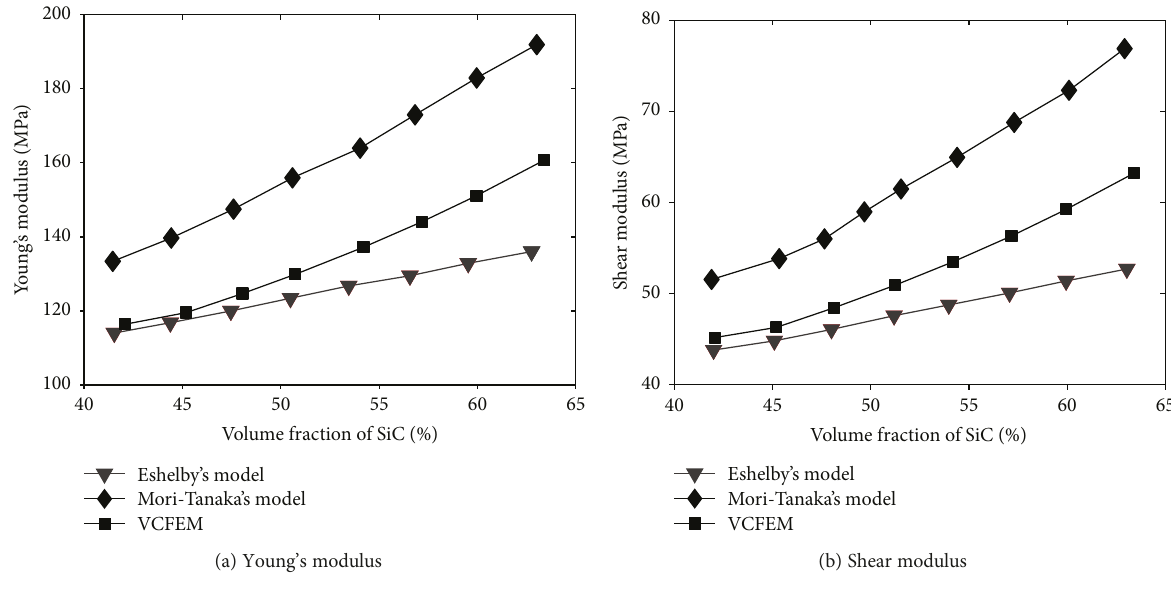
Figure 6: E ff ective modulus of aluminum – SiC composites versus the V